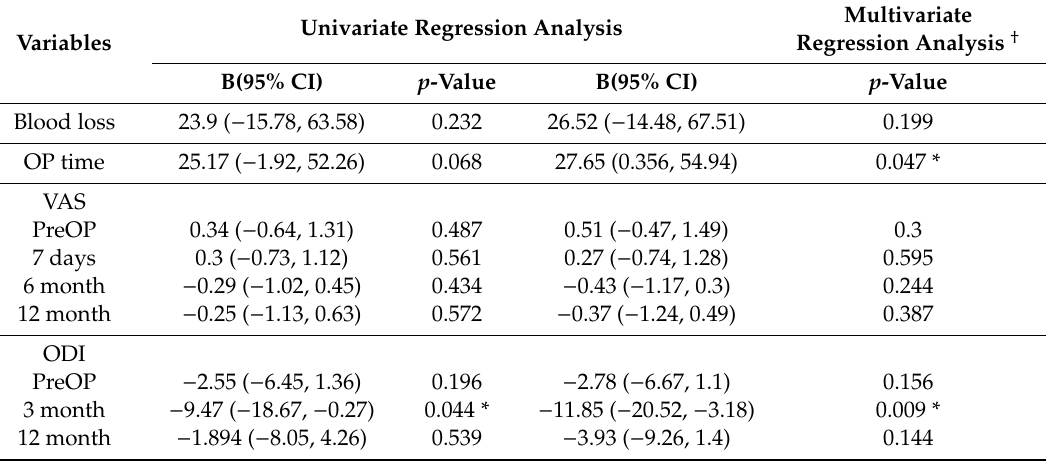
Table 2. Perioperative data and outcomes.